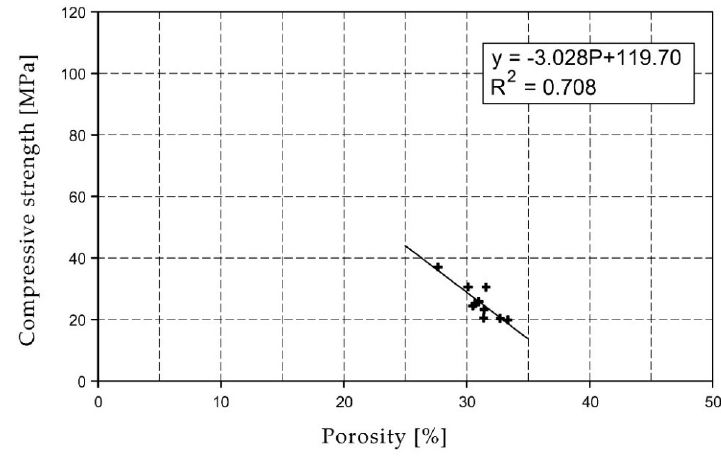
Figure 10. Compressive strength of O06XX series bricks.